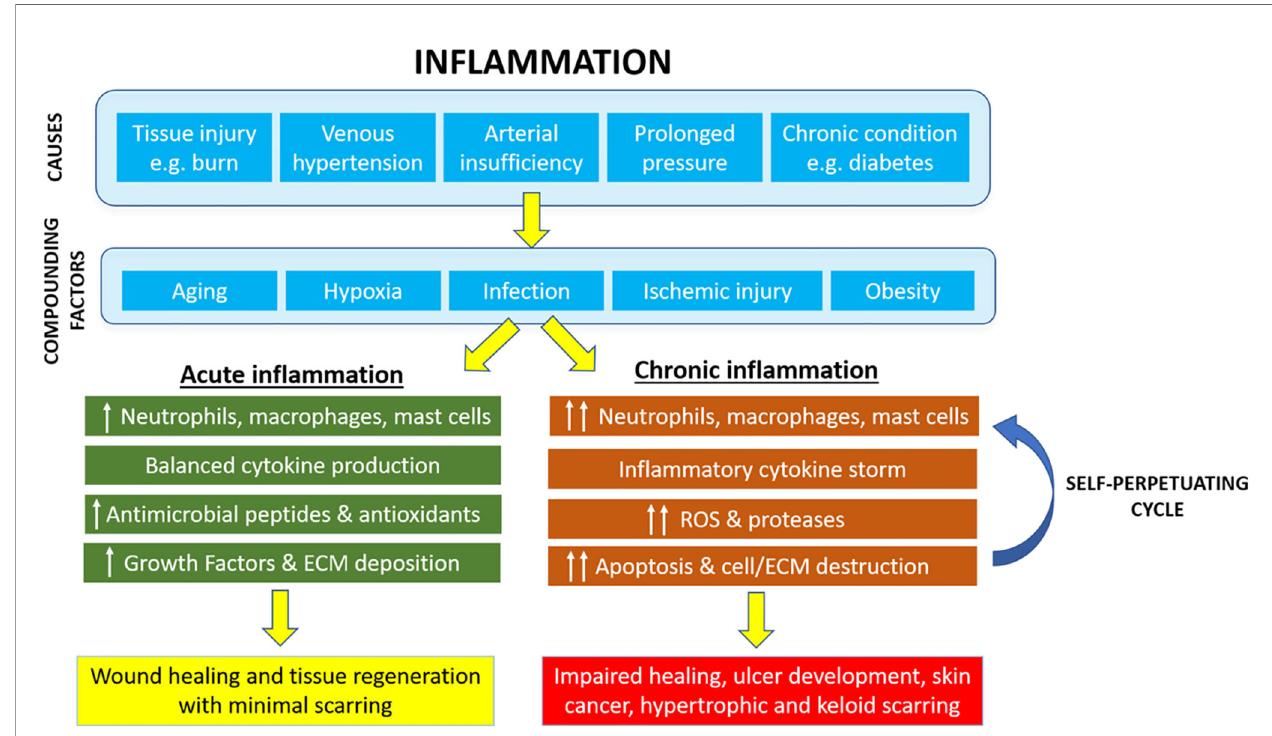
FIGURE 1 | Cutaneous in fl ammation and its role in pathophysiology of chronic wounds and tissue